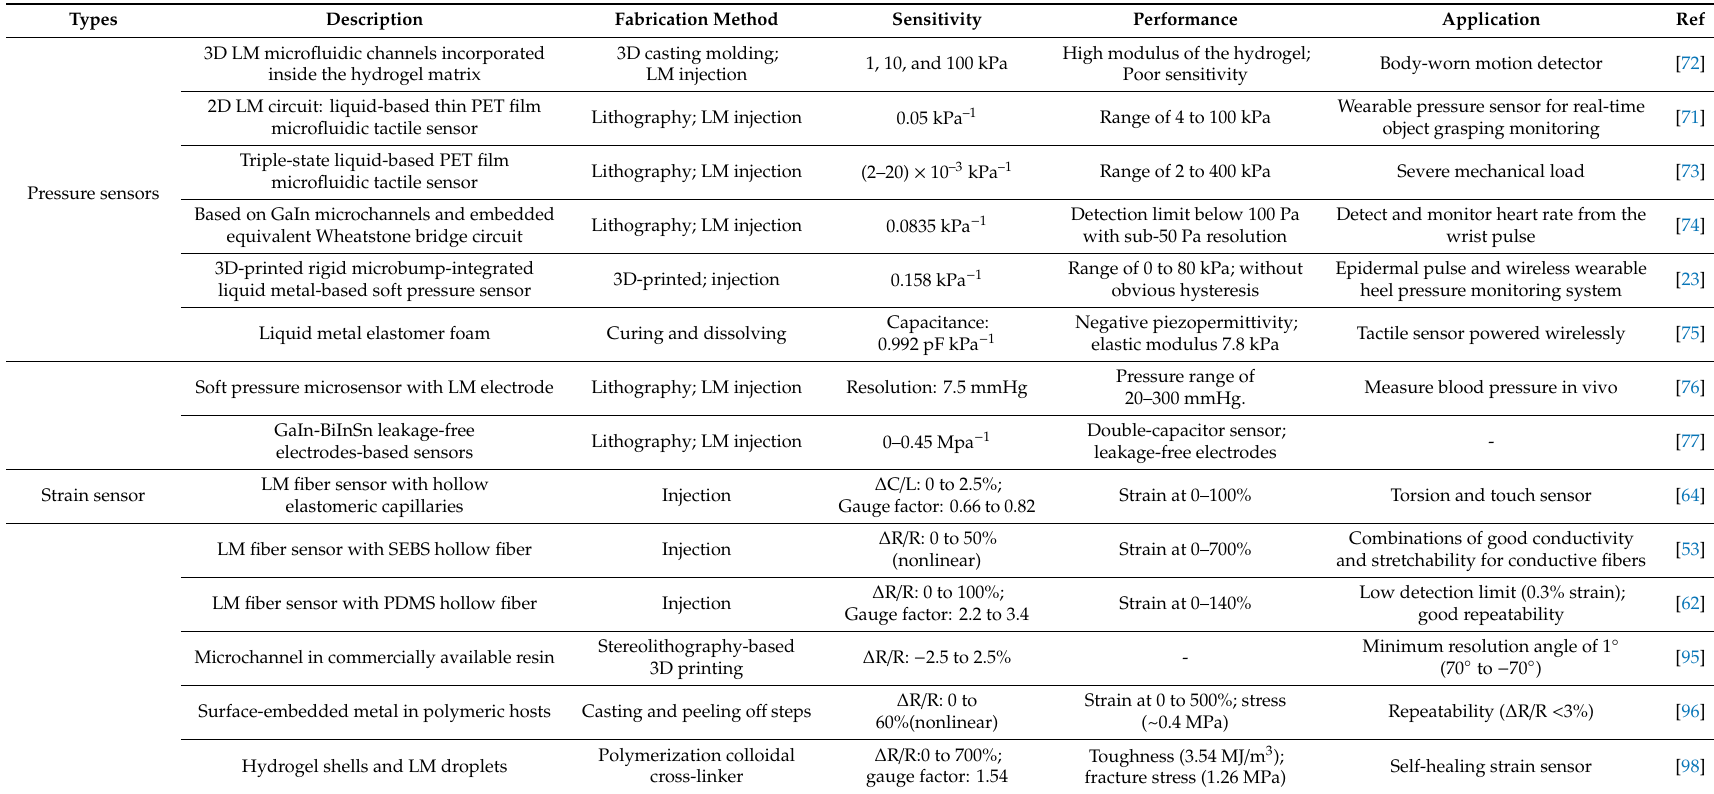
Table 1. Summary of mechanical sensor based on liquid